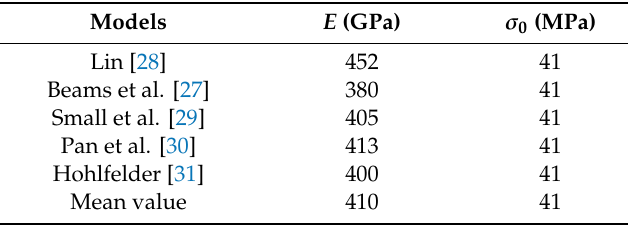
Table 3. Bulge test results depending on the models used.